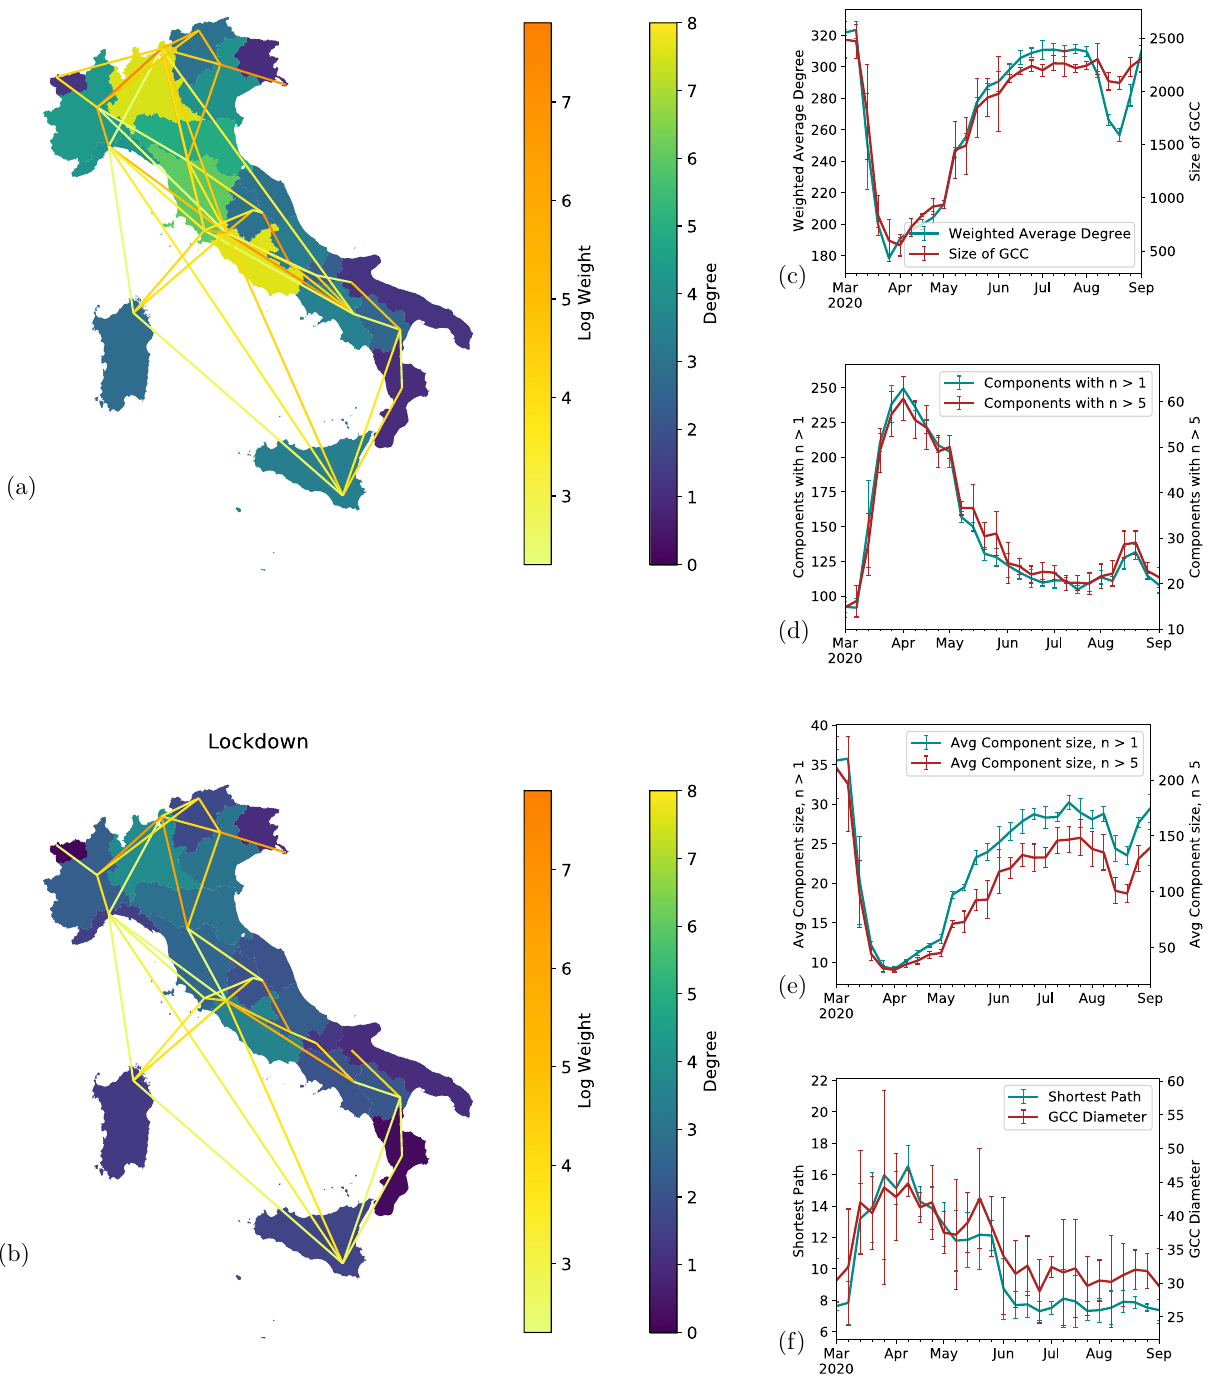
Figure 1. Network characteristics of traffic before and during lockdown for the coarsest (left) and finest (right) resolutions. ( a ) Region-level mobility before lockdown. Region color shows the daily average simple degree for business days before lockdown measure were implemented. The edge colors show the log of the weighted link, i.e. the daily number of people traversing each edge. ( b ) Mobility during lockdown, color scales matching ( a ). Many of the existing edges have failed, and those that remain are much weaker. ( c ) Average weighted degree (teal) and size of the Giant Connected Component (GCC, red) averaged over a week, error bars showing the standard deviation for the period. ( d ) Number of non-isolated components (teal) and number of components with more than 5 nodes in them (red). ( e ) Average size of: non-isolated components (teal), and components larger than 5 nodes (red). ( f ) Average shortest path length (teal) and the diameter of the GCC